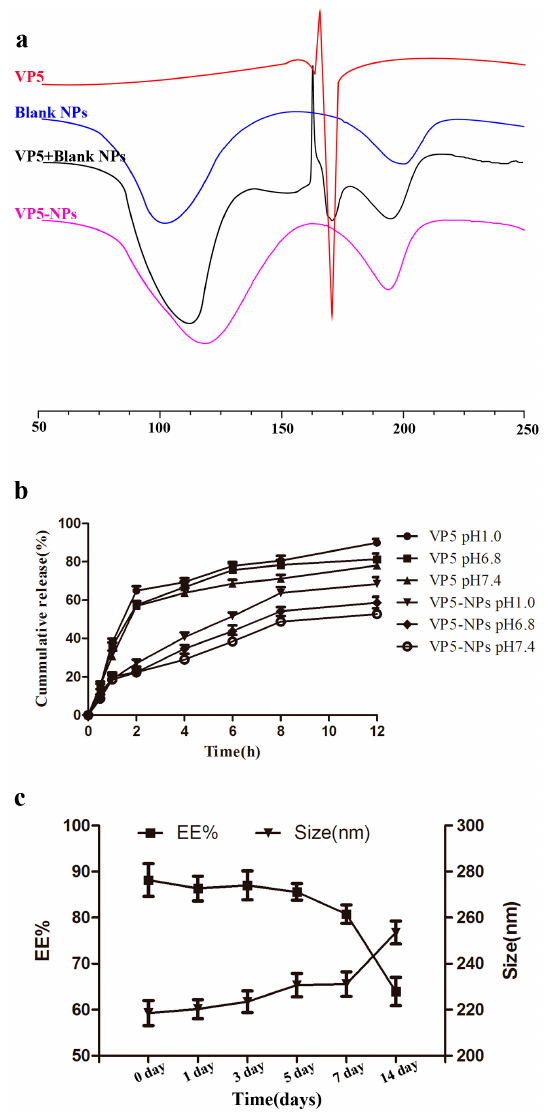
Figure 3. Characterization of VP5-NPs by differential scanning calorimetry (DSC), in vitro release